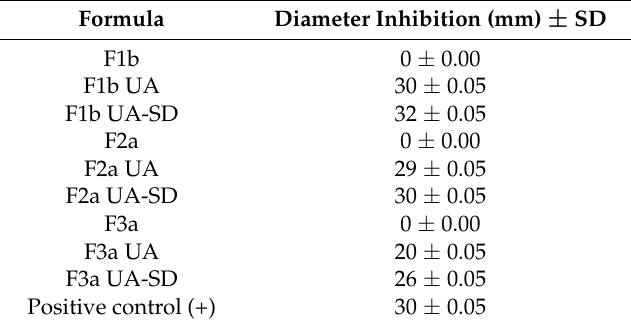
Table 7. Result of anti-bacterial